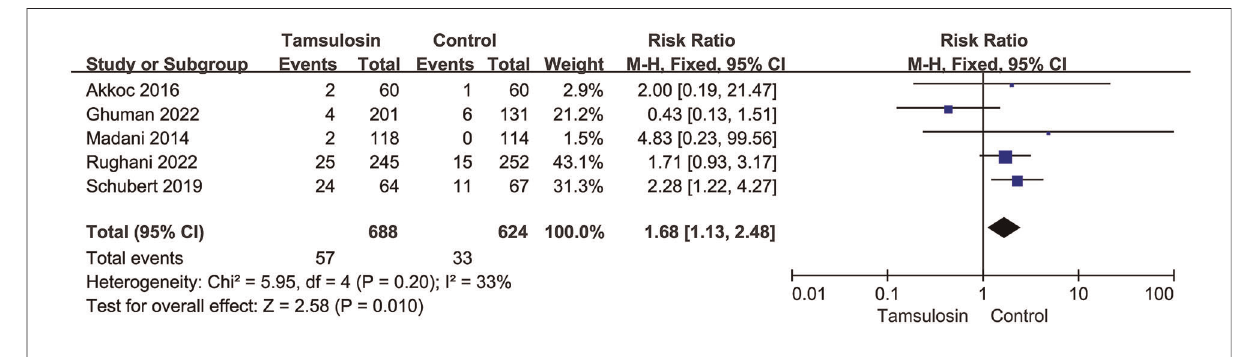
FIGURE 7 Forest plot for total adverse